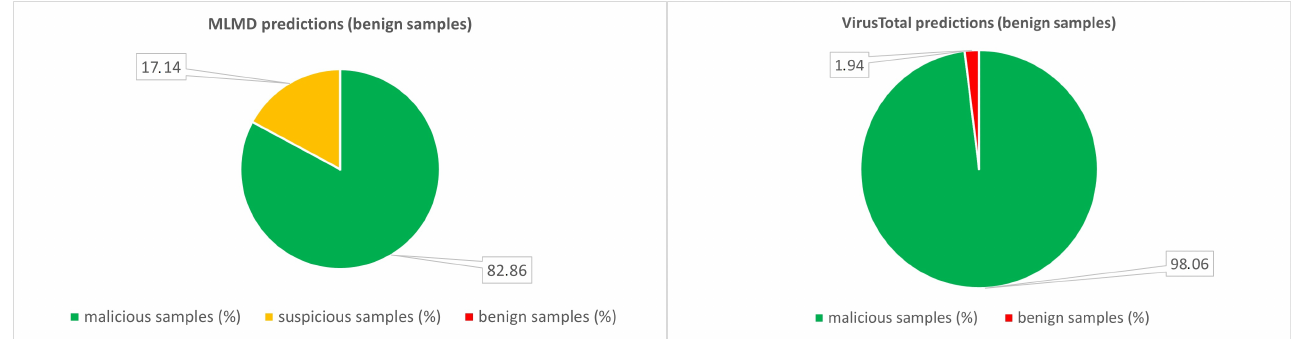
Figure 12. Comparison of classifications of malicious